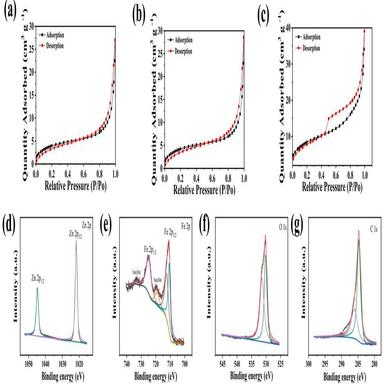
N2 adsorption-desorption isotherms of (a) ZFO/C-400, (b) ZFO/C-450, and (c) ZFO/C-500; XPS spectra and fitted curves of (d) Zn 2p, (e) Fe 2p, (f) O 1 s, and (g) C 1 s in ZFO/C-450.